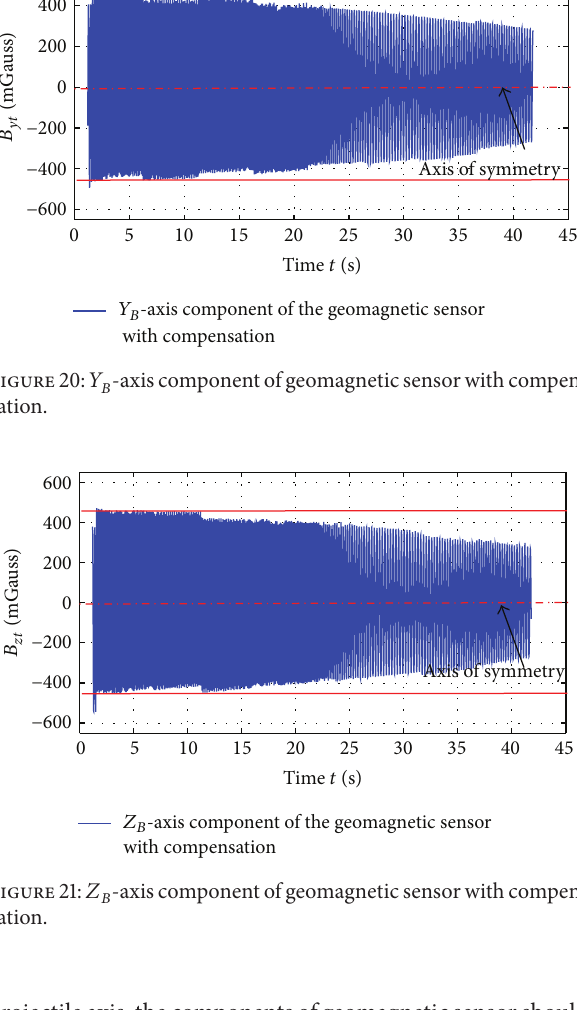
Figure 18: 𝑌 𝐵 -axis component of geomagnetic sensor without compensation.